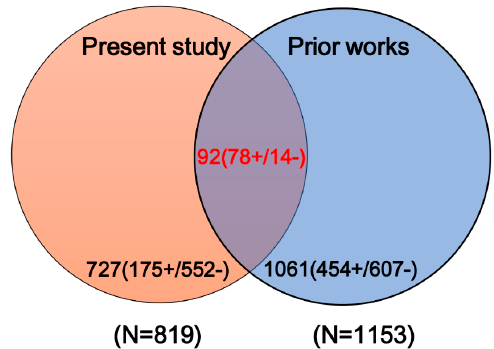
Figure 4. Venn diagram of compounds from prior studies and the present study. “ + ” and “ − ” denote the number of DILI-positives and DILI-negatives, respectively.